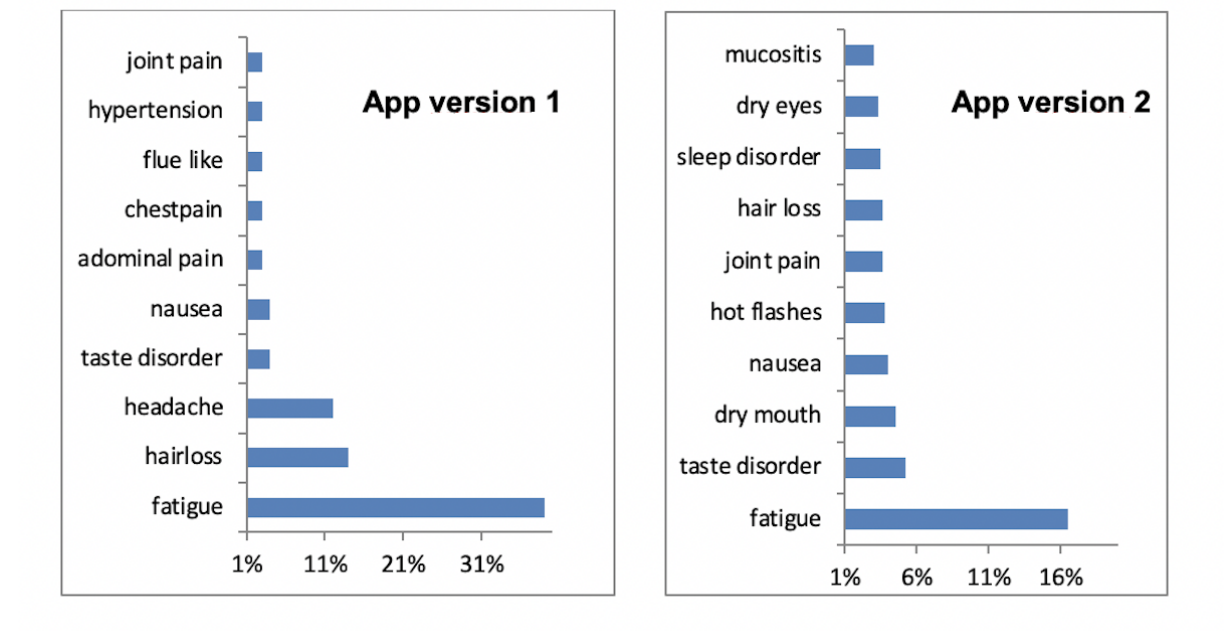
Figure 3. Most frequently reported side-effects in both app versions.